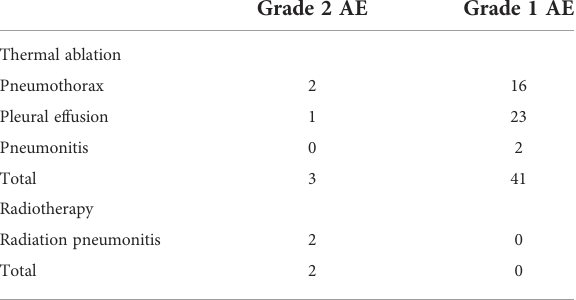
TABLE 4 Adverse events for two